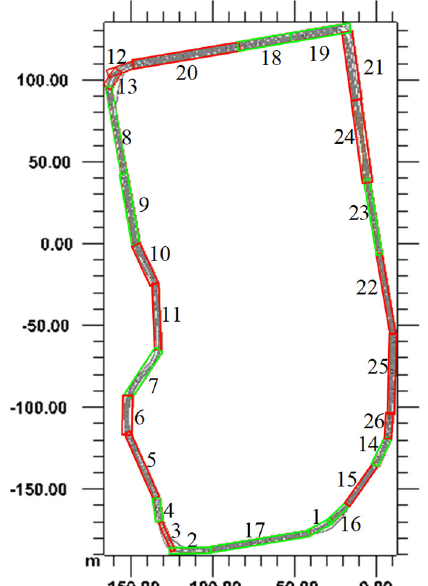
Figure 9. 3D GPR image of the road around the Zall Stadium